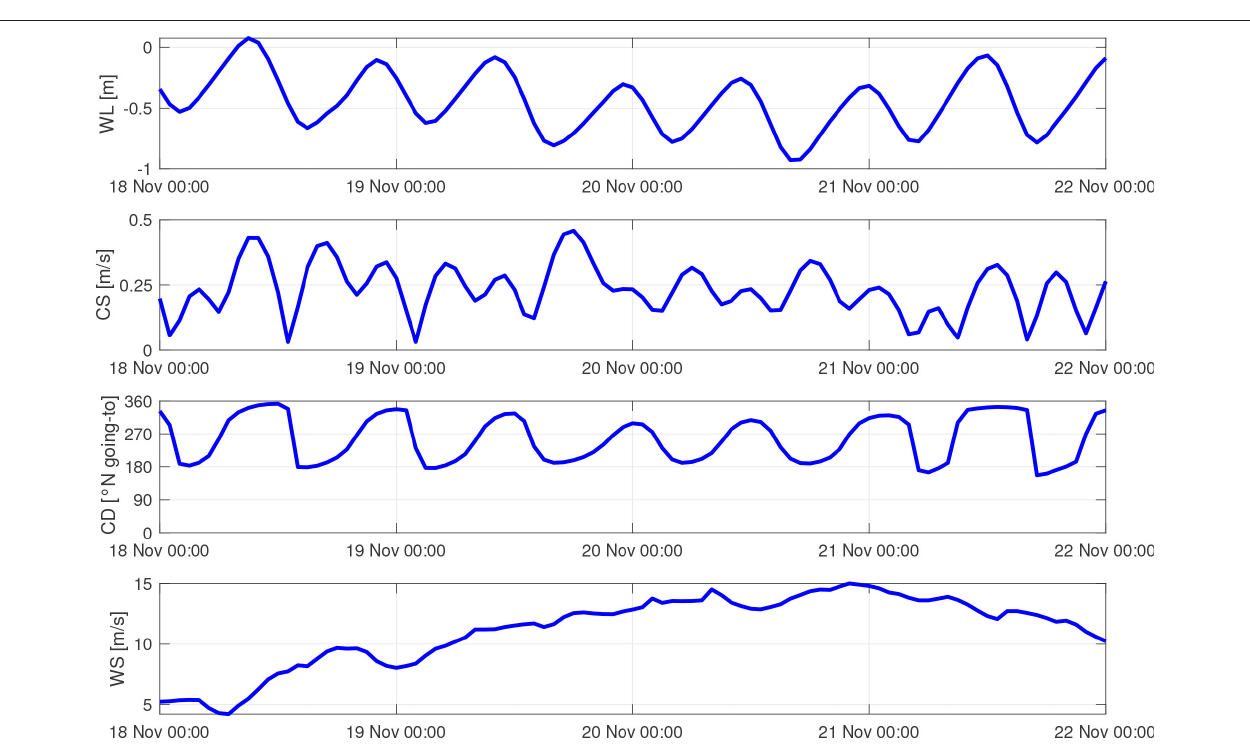
FIGURE 3 | Time series of Water Level (WL), Current Speed (CS), Current Direction (CD), and Wind Speed (WS) extracted at the Site (see Figure 2 ) from the 5-day forecast